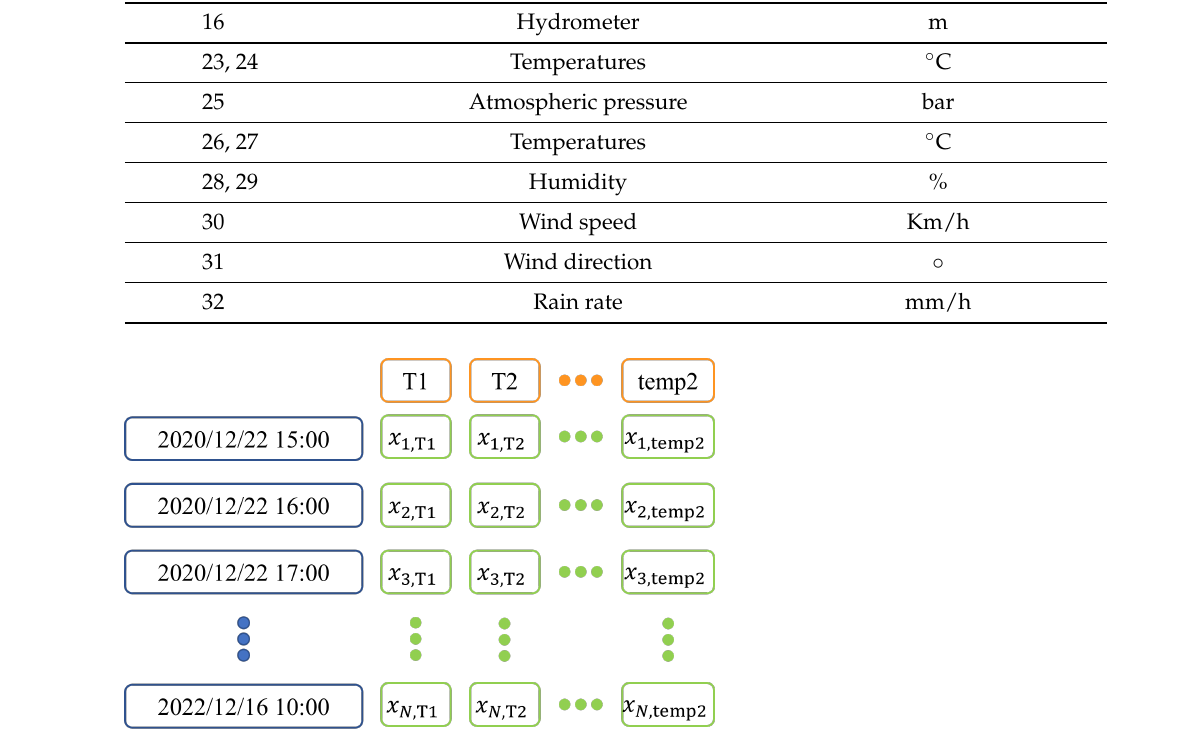
Figure 2. Data arrangement after